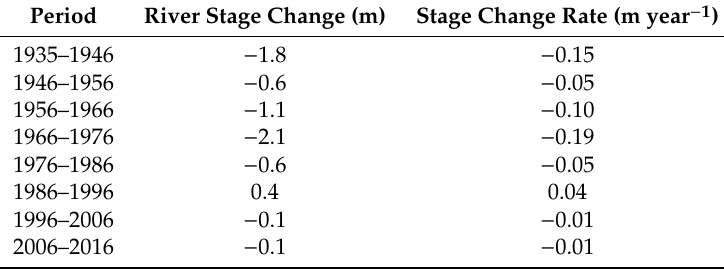
Figure 10. Changes in the relationship between daily mean river stage and discharge at Simmesport (i.e., 8000 m 3 s − 1 ) between 1935 and 2016. Table 2. Decadal rive stage changes under a specific discharge of 8000 m 3 s − 1 at Simmesport between 1935 and 2016 (Figure 8).